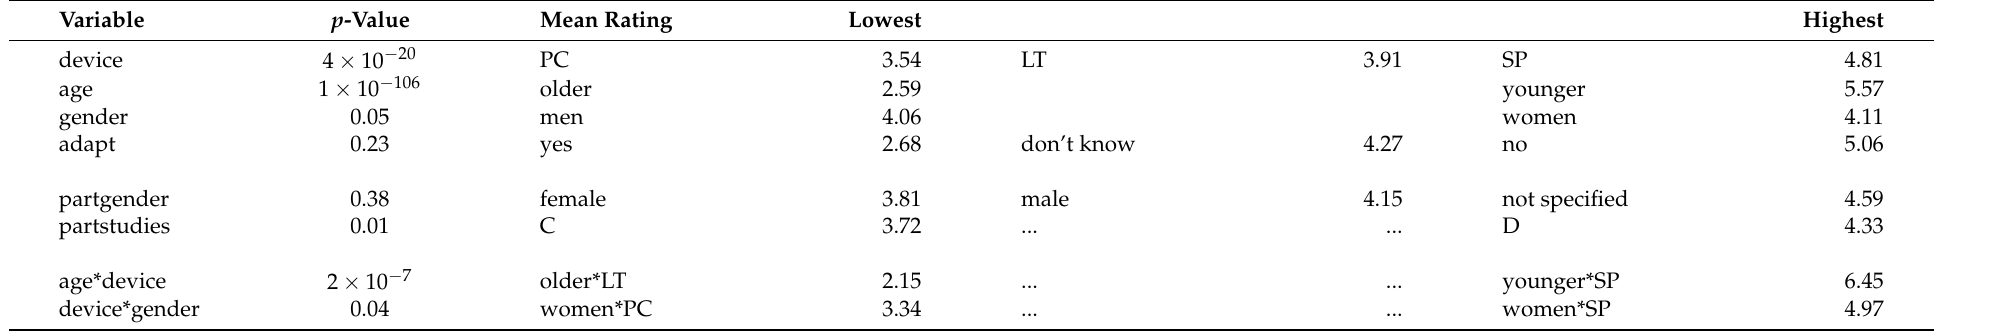
Table A1. Likelihood of use, p -value from ANOVA with associated mean ratings.